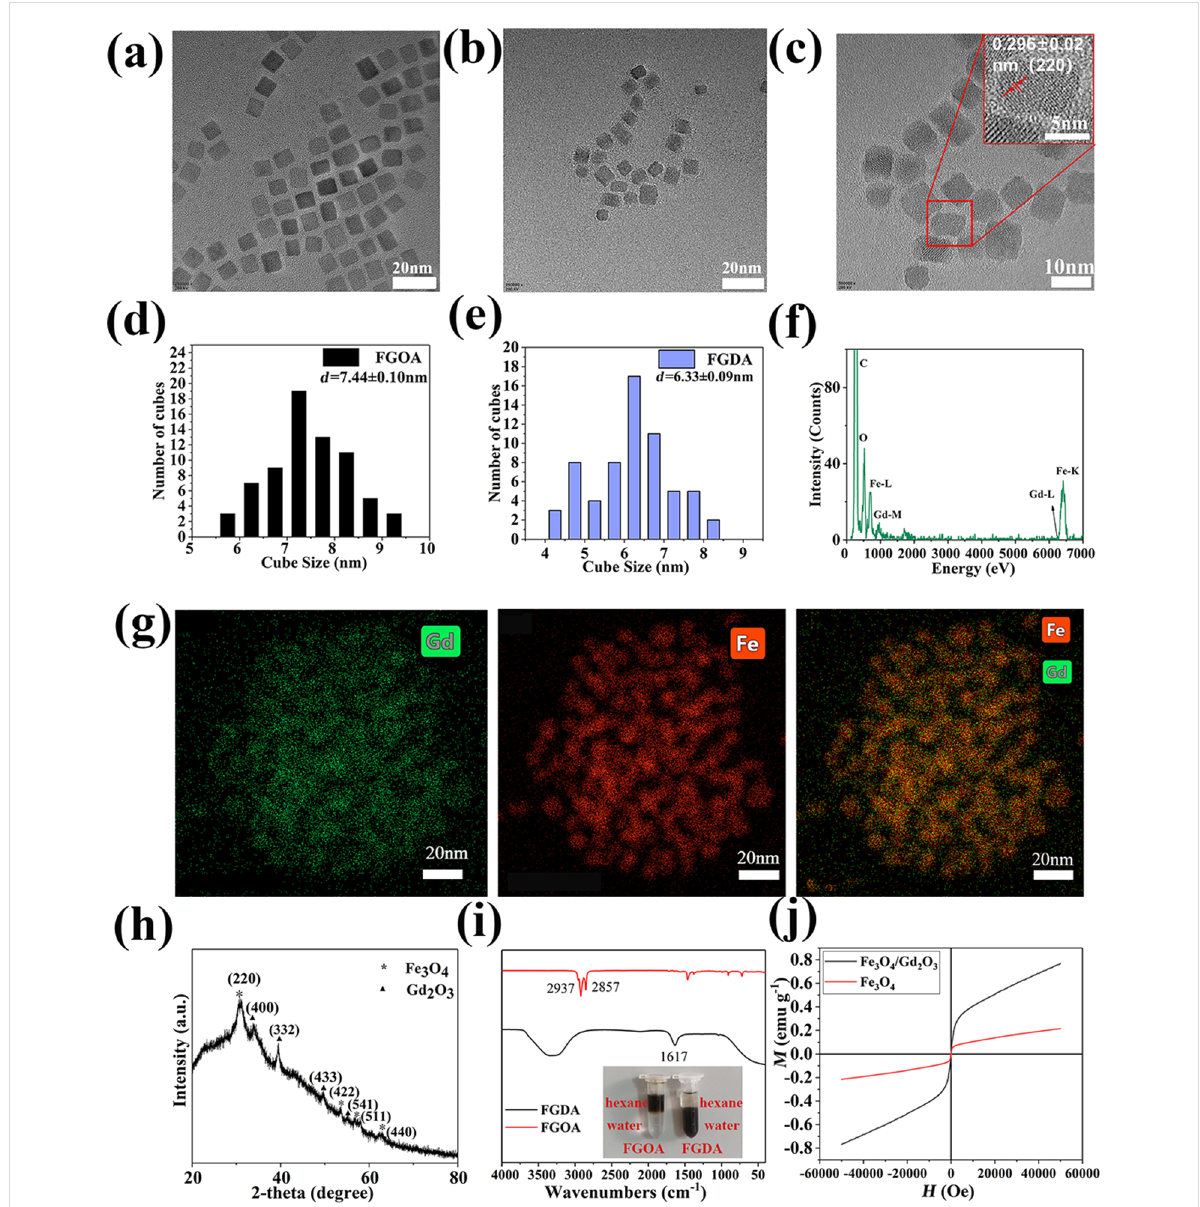
Figure 2: TEM and HRTEM images of FGOA (a) and FGDA (b, c) nanocubes with their respective size distributions (d, e). (f) The EDS spectrum shows the main elements that constitute the FGDA nanocubes. (g) The EDS mapping shows that Gd (green, left panel) and Fe (red, middle) are ho- mogeneously distributed throughout the nanocubes (overlay, right panel). (h) The XRD pattern of FGDA nanocubes shows that the spectrum peaks coincide with the peaks of pure Fe 3 O 4 (asterisks) and Gd 2 O 3 (triangles). (i) FTIR spectra of FGOA (red line) and FGDA (black line) nanocubes. (j) Field-dependent magnetization curves ( M – H ) of Fe 3 O 4 /Gd 2 O 3 (black line) and Fe 3 O 4 (red line) measured using a physical property measurement system (PPMS) at 300 K. All scale bars are 20 nm except for C, which is 10 nm.